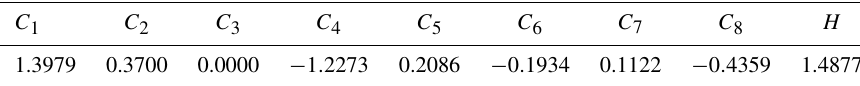
Table 2. Coefficients in the GMPE.